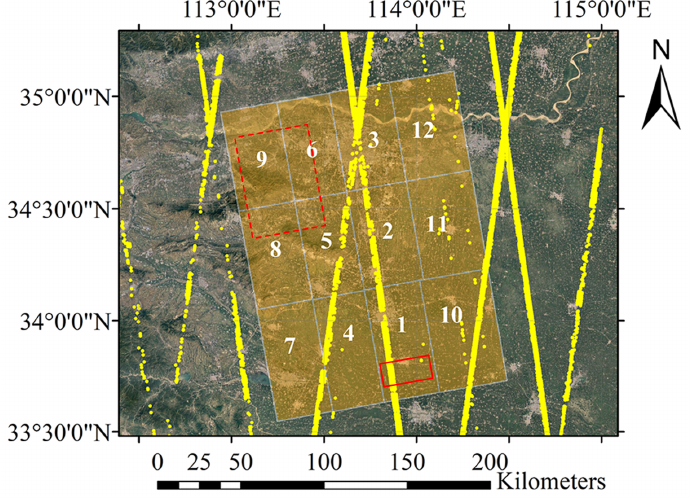
Figure 5. The location of GLAH14 and CoSSC data in the experimental area. The yellow points are GLAH14 data from ICESat. The rectangular windows are the shapes of CoSSC data, and the numbers on them are arranged in the order of their acquisition